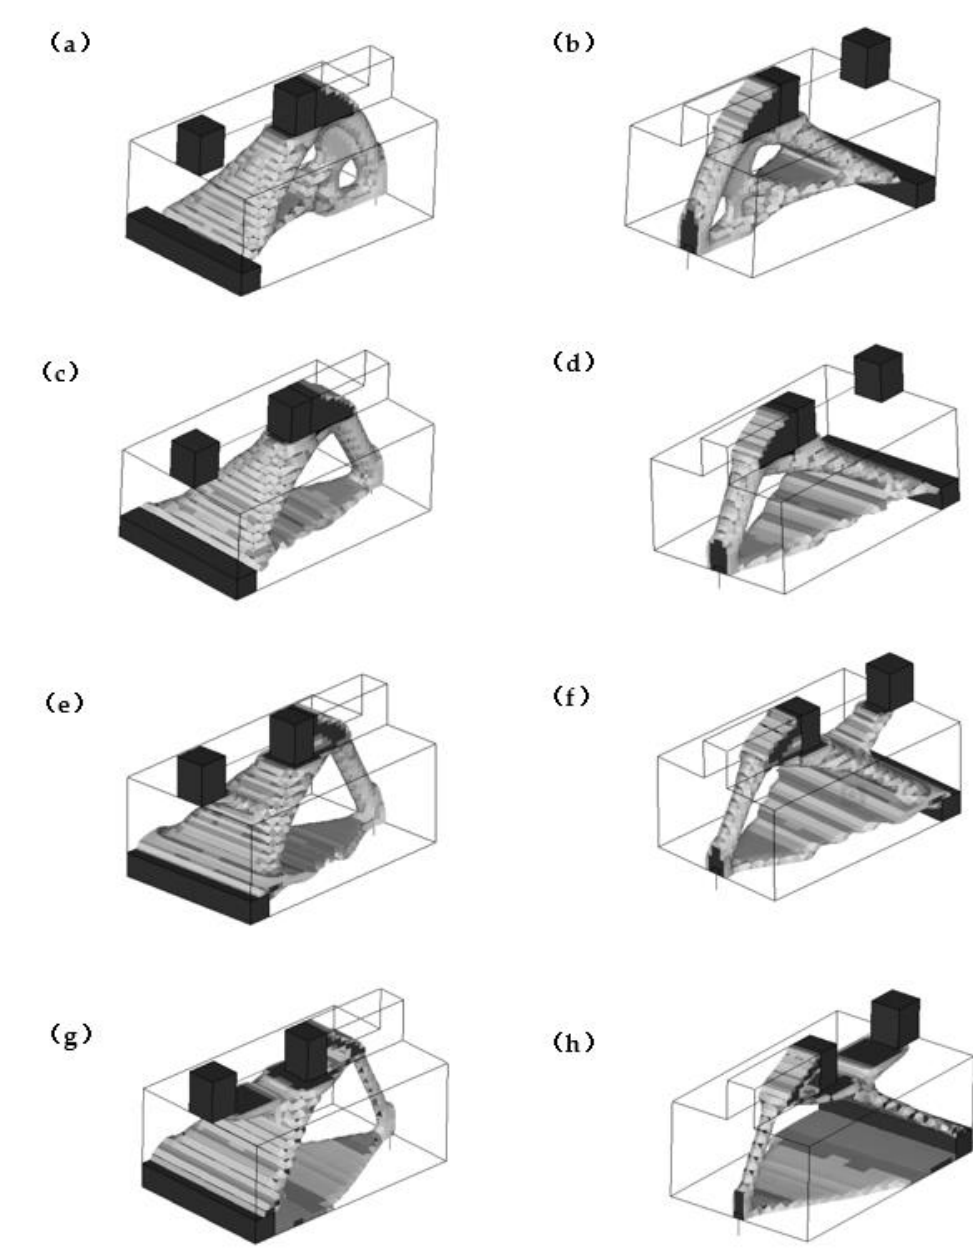
Figure 7. ( a , b ) continuous optimized layout different views with weighting coefficient 1 of the 1st eigen-frequency; ( c , d ) continuous optimized layout different views with weighting coefficient 100 of the 1st eigen-frequency; ( e , f ) continuous optimized layout different views with weighting coefficient 1000 of the 1st eigen-frequency; ( g , h ) continuous optimized layout different views with weighting coefficient 2250 of the 1st eigen-frequency.